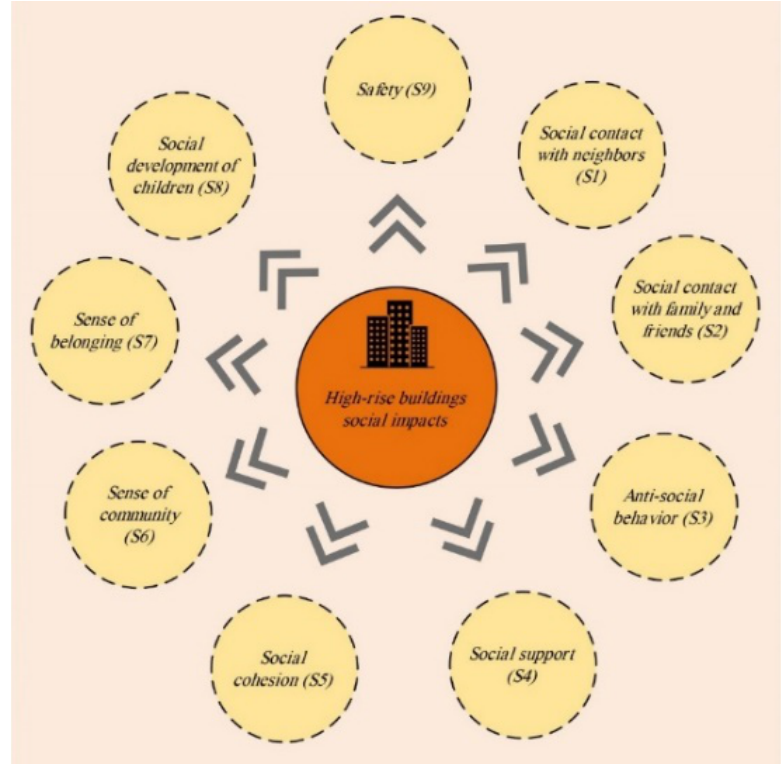
Figure 1. High-rise residential buildings’ social impacts.